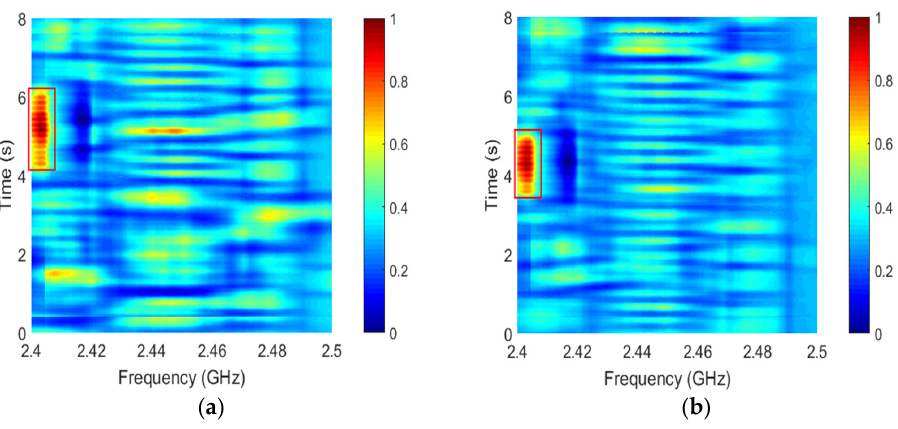
Figure 23. The result for the CFAR method indoors at distances of ( a ) 5 m and ( b ) 10 m. Table 4. Parameter estimation errors for UAV detection using three methods in an indoor